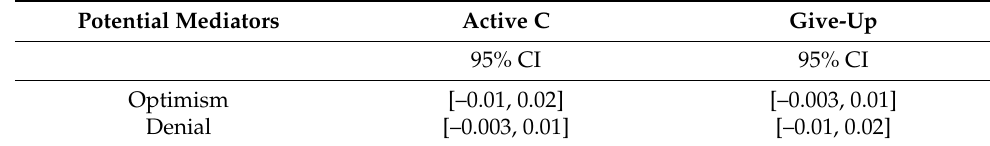
Table 5. Moderated mediation indices with different mediator